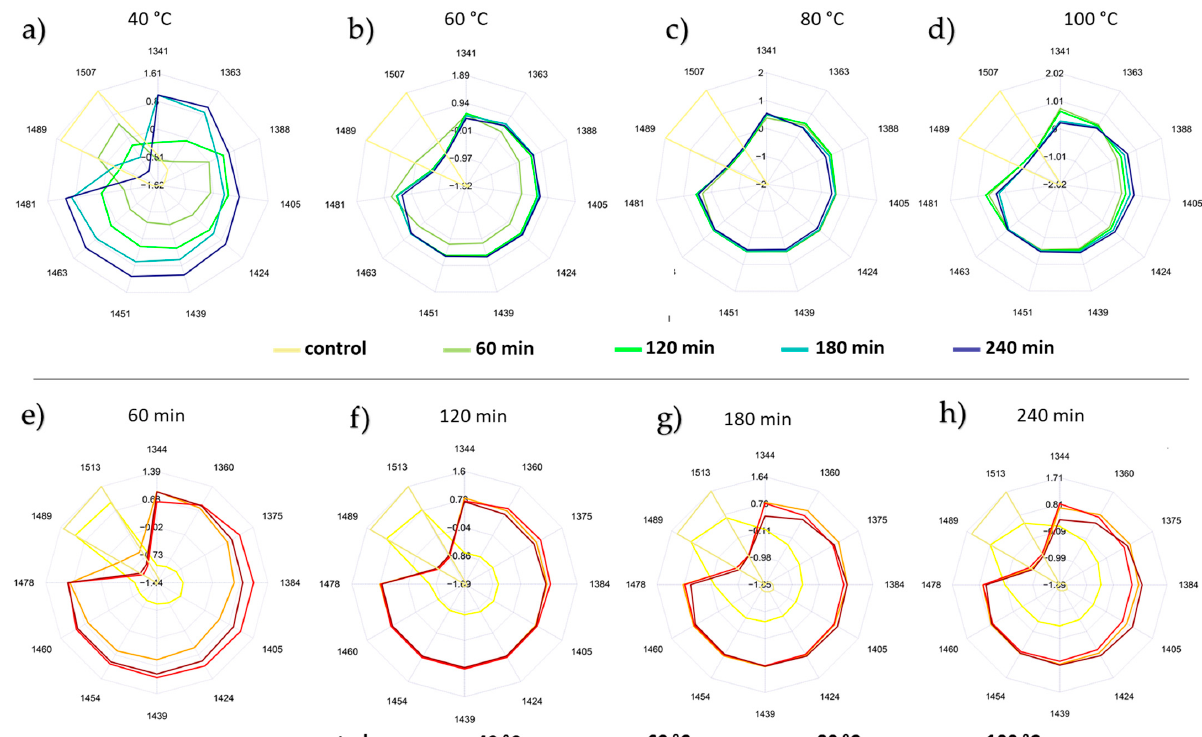
Figure 4. Aquagrams of the sunflower honey: ( a – d ) aquagrams showing pattern of time intervals; ( e – h ) aquagrams showing the pattern of temperature levels.